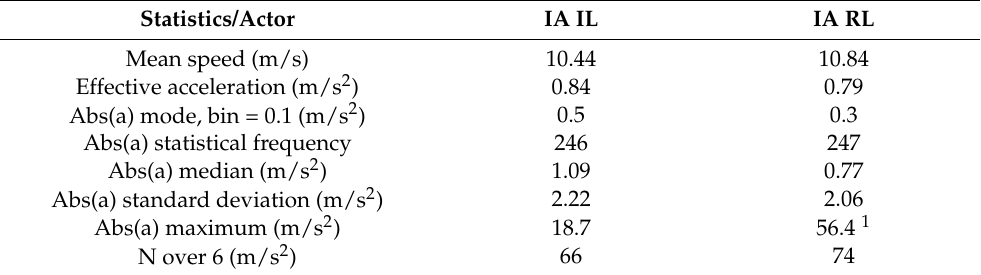
Figure 16. Case 2. Automobile’s revolutions per minute and gear number. Table 11. Case 2. Mean speed and statistics derived from net acceleration of IAs on the test track.